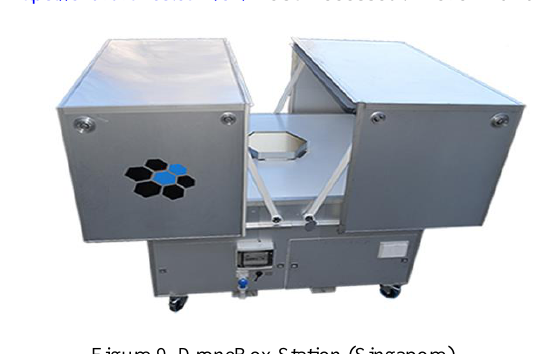
Figure 9. DroneBox Station (Singapore) http://www.h3dynamics.com/products/drone-box/ Last